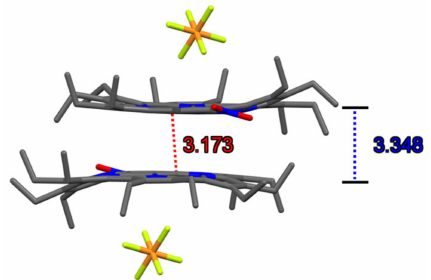
Figure 6. Crystal structure of ( 2a • + [PF 6 − ]). The closest atomic (red) and plane (blue) distances are indicated.